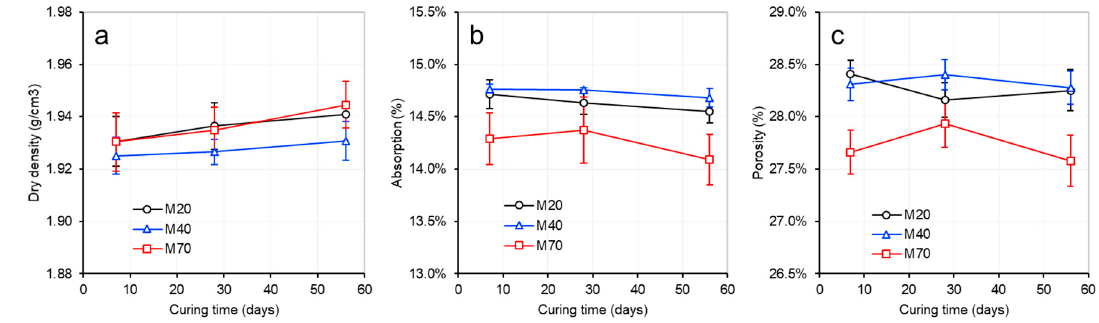
Figure 2 . Physical properties of the different mortars. ( a ) Dry density, ( b ) Absorption, and ( c ) Porosity.